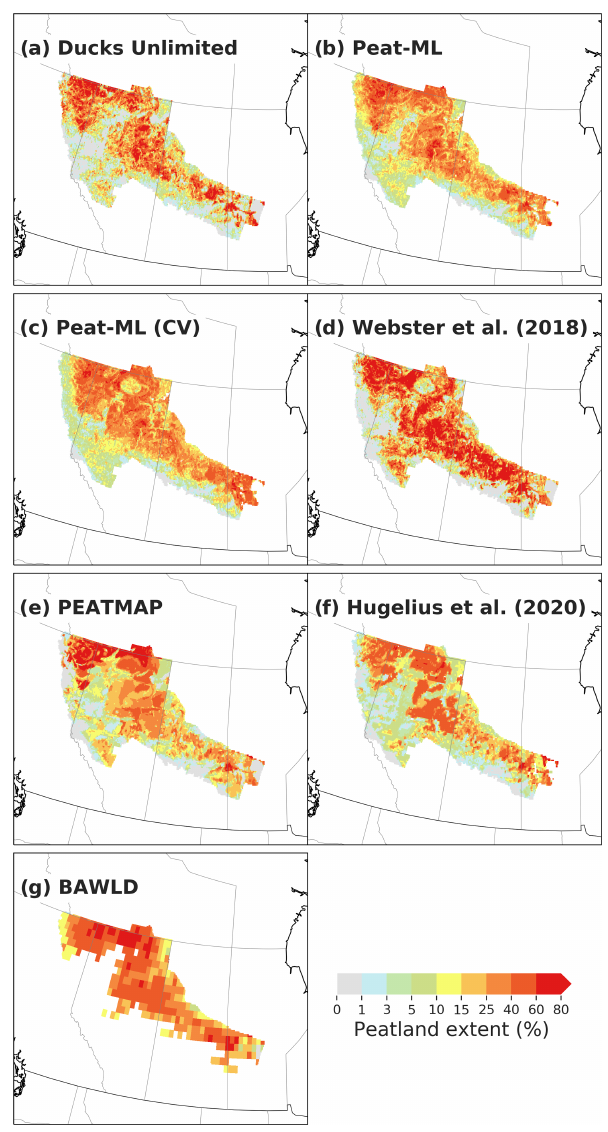
Figure A8. Maps of peatland extent for the Boreal Plains of